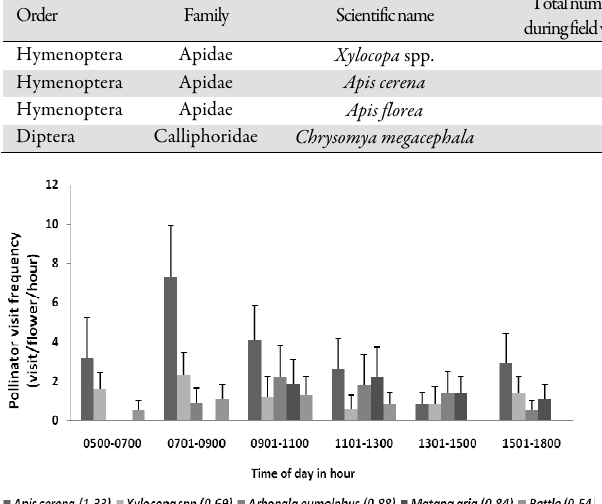
Table 3. Insects visiting the flowers of Lagerstroemia speciosa in tropical forest site of Mizoram Order